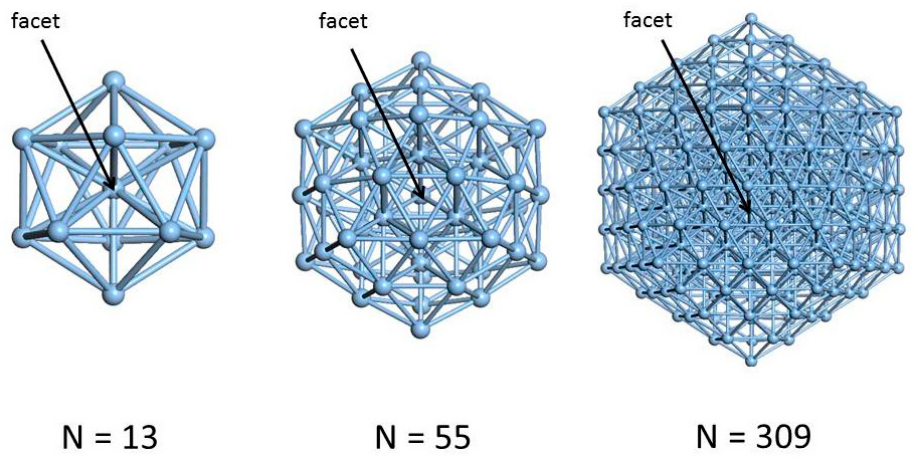
Figure 3. Schematic view of model icosahedron nanoparticles with different sizes showing the location of the “facet” active + sites.